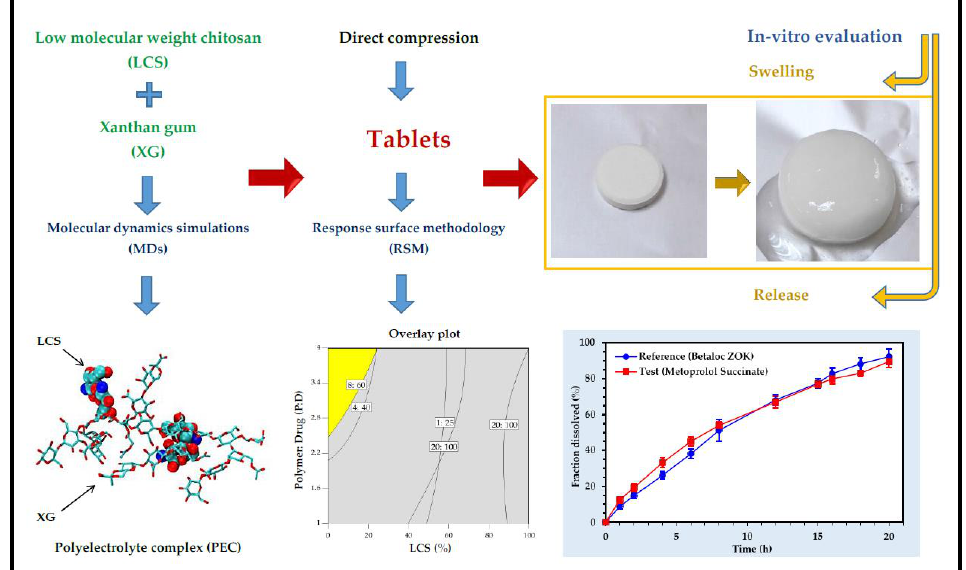
Figure 4. Development of xanthan gum-chitosan directly compressed tablets for the controlled re- lease of metoprolol succinate [69]. Reproduced from ref [69]. Copyright 2020 American Chemical of metoprolol succinate [69]. Reproduced from ref. [69]. Copyright 2020 American Chemical Society.